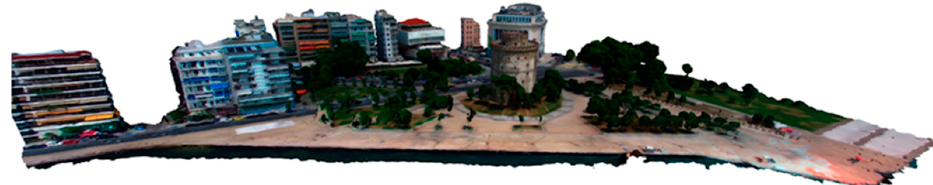
Figure 9. The freely available photogrammetrically mapped area used for the demonstration.